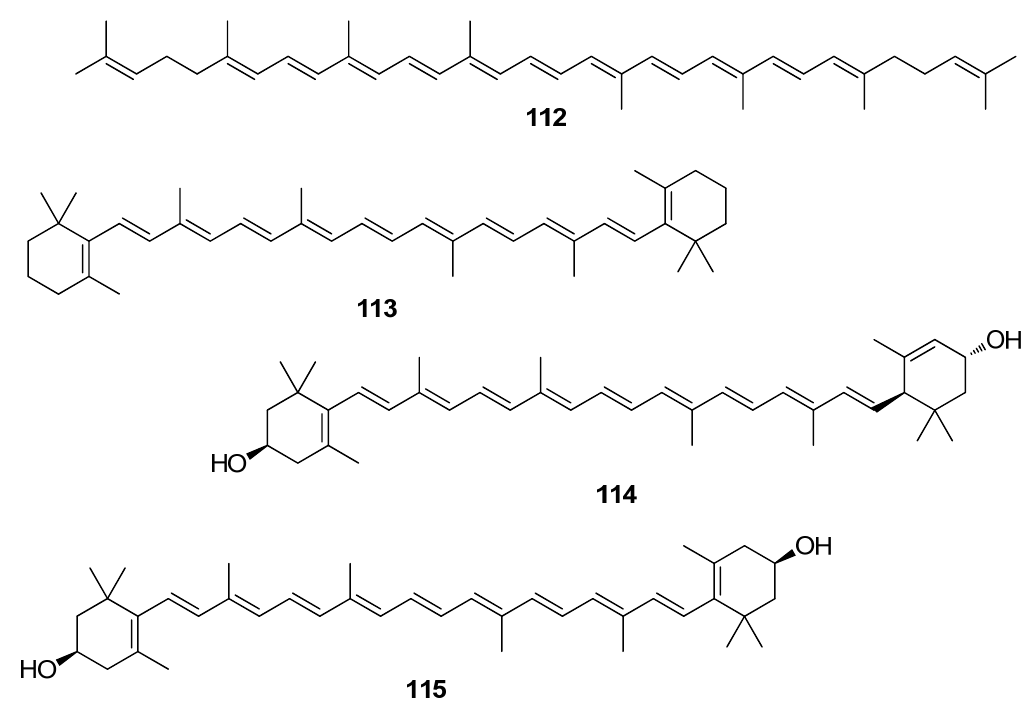
Figure 11. Chemical structures of compounds 112 – 115 .